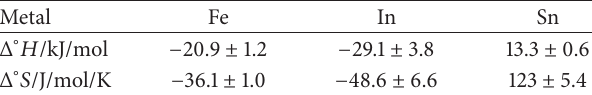
SO . Values are 2 4